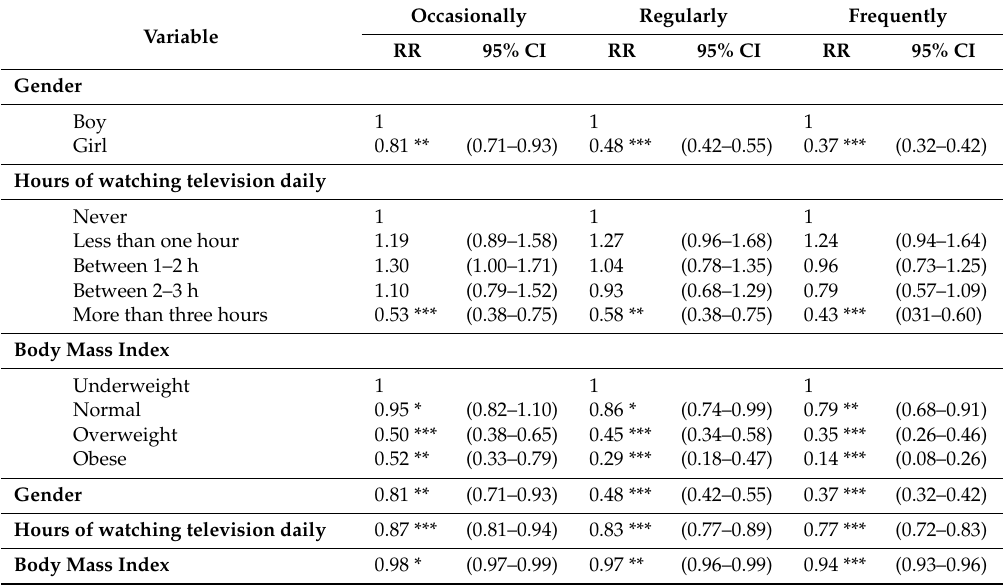
Table 4. Multinomial Logistic Regression of physical activity practice in relation to gender, hour of watching television, and Body Mass Index, adjusted by